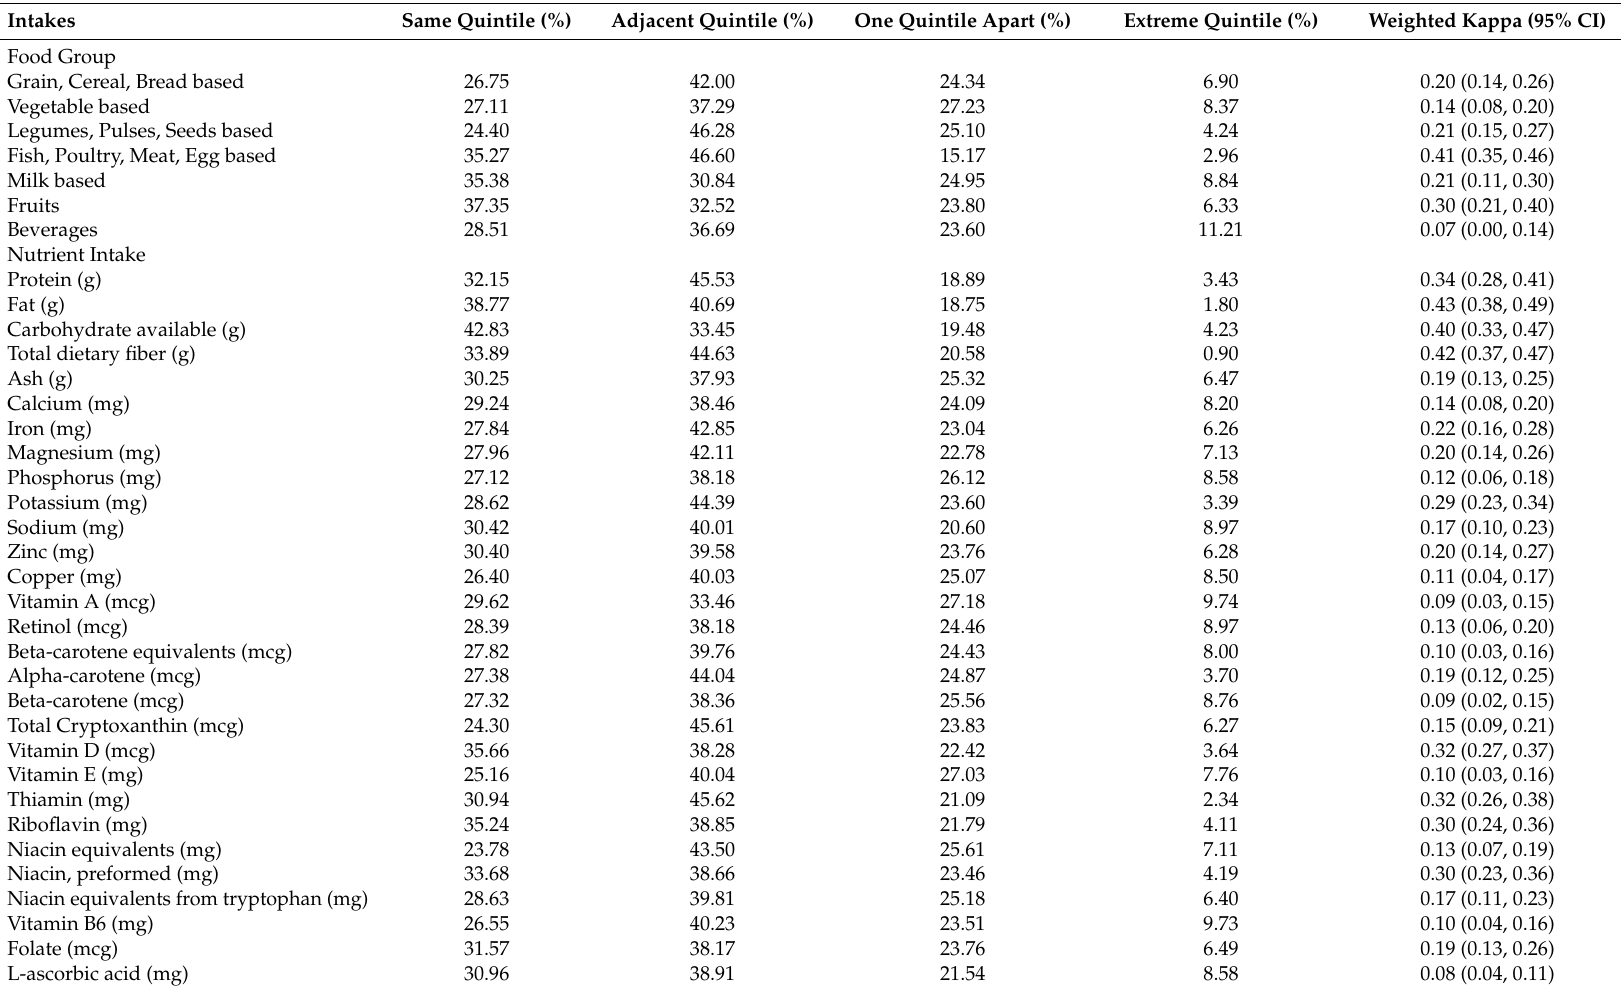
Table 5. Agreement of cross-classification quintiles for food intake assessed by food diary (FD) and by semi-quantitative food questionnaire (FFQ). Intakes Same Quintile (%) Adjacent Quintile (%) One Quintile Apart (%) Extreme Quintile (%) Weighted Kappa (95% CI) Food Group Grain, Cereal, Bread based